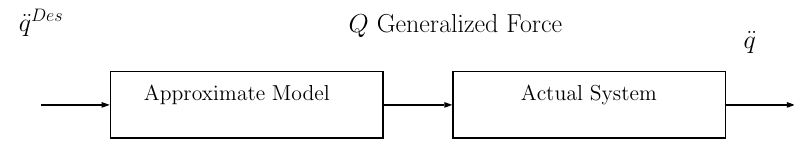
Figure 1. Interpretation of the CTC scheme in different